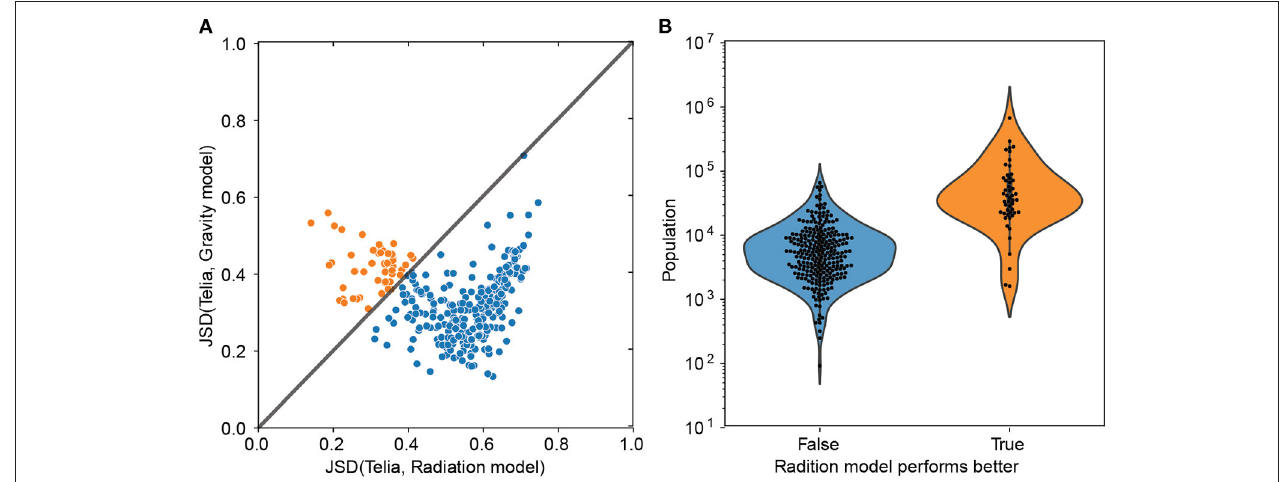
FIGURE 3 | (A) The Jensen-Shannon Divergence (JSD) between empirical signatures and signatures from theoretical models. Orange dots represent cities whose signatures match better with the radiation model, and blue dots represent cities for which the gravity model works better. A low value of the JSD indicates a high level of similarity. (B) City population distribution for the two groups. In group I (blue), the gravity model performs better than the radiation model, and the opposite is true for group II